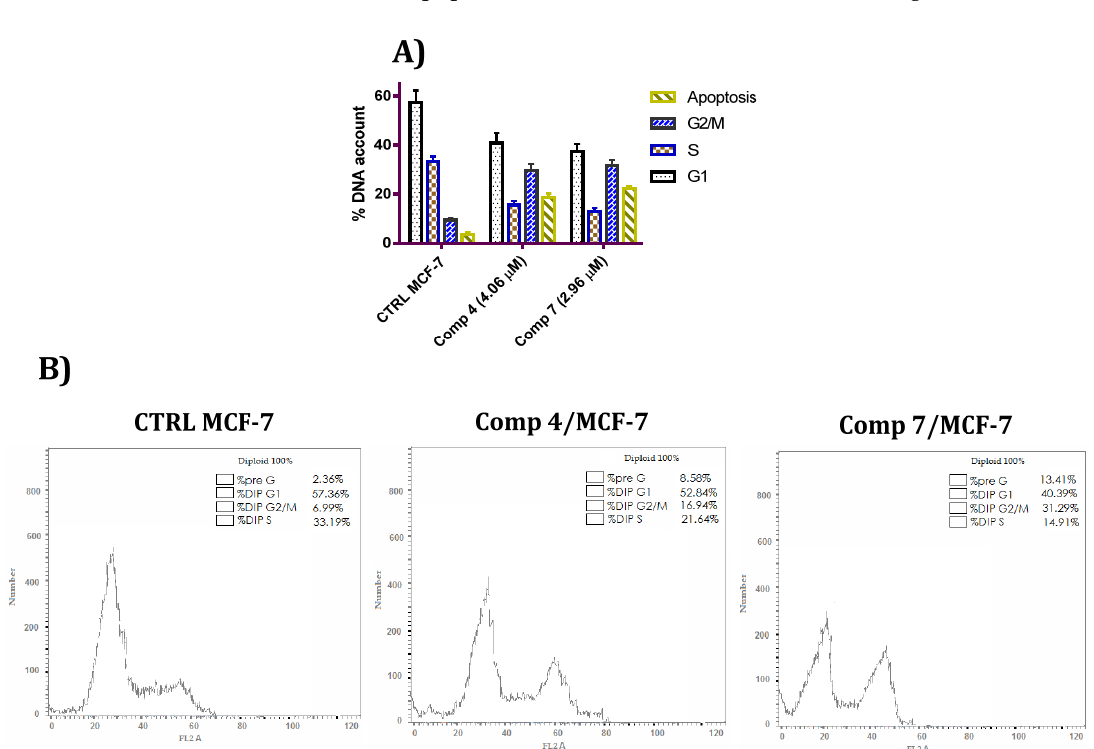
Figure 3. Graphical representation of tubulin polymerization inhibition effect of compounds 4 and 7 at their IC 50 ( μ M).